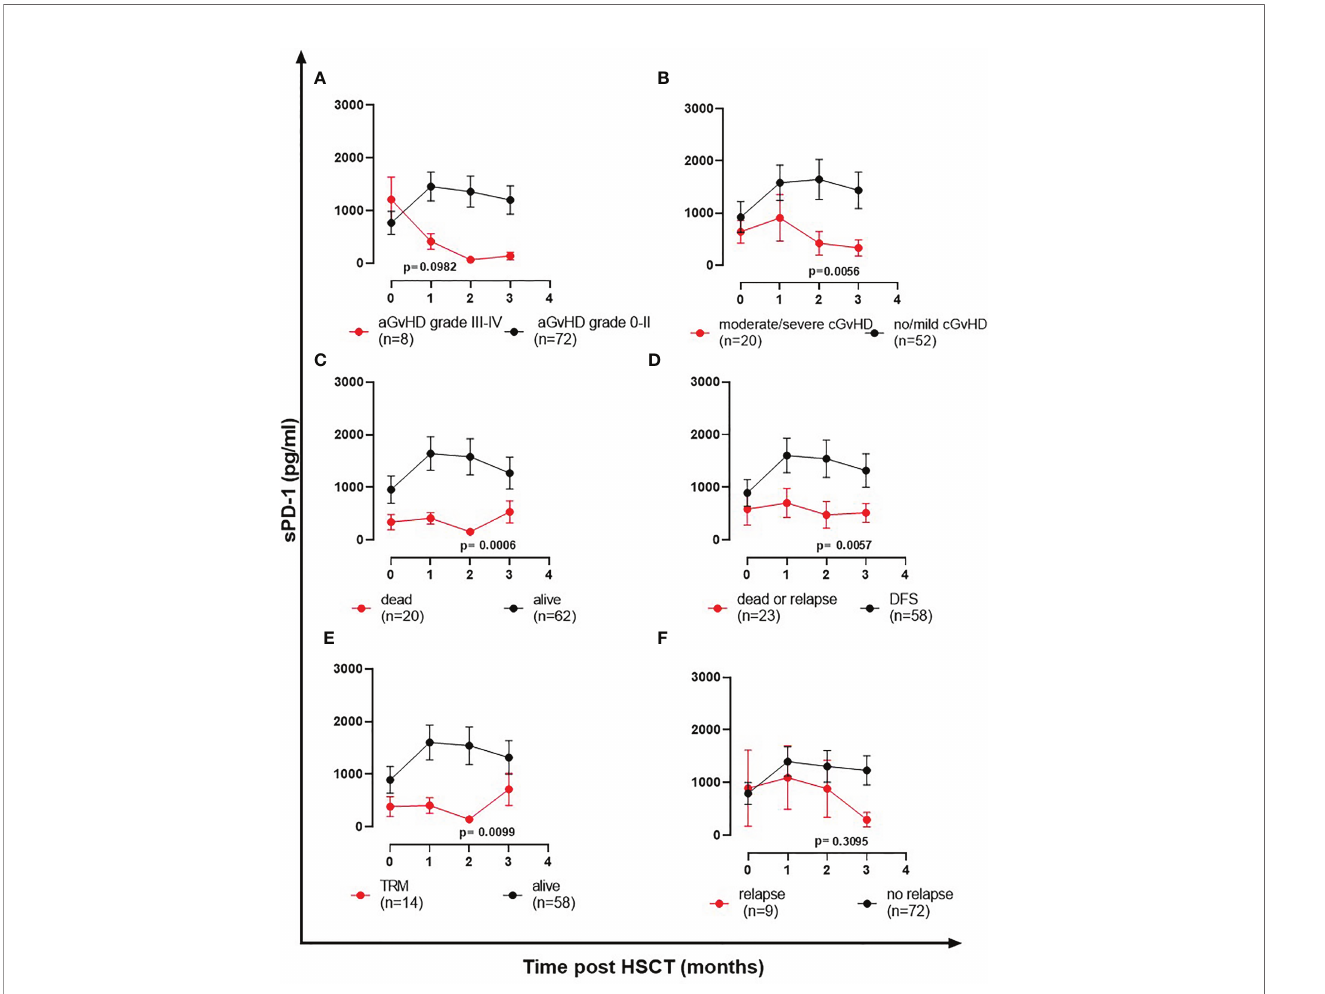
FIGURE 3 | The course of sPD-1 levels in relationship to clinical outcome post HSCT. Course of sPD-1 levels in patients with (A) aGvHD grade III-IV (red line) versus aGvHD grade 0-II (black line), (B) moderate/severe cGvHD (red line) versus no/mild cGvHD (black line), (C) patients passed away (red line) versus patients being alive (black line) at month three, (D) patients passed away or with relapse (red line) versus patients with disease-free survival (black line), (E) patients with transplant-related mortality (TRM) and not due to relapse (red line) versus patients being alive (black line), and (F) patients experiencing recurrence (red line) versus patients without relapse during the follow-up time. Data are presented as mean ± SEM before HSCT (0) and one, two, three month(s) post HSCT. Manifestation of aGvHD or cGvHD could not be evaluated for all patients due to death or missing clinical